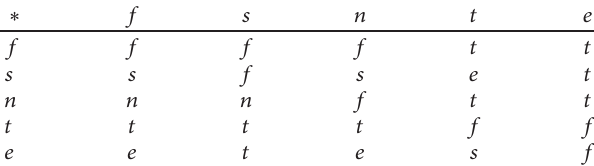
Table 5: Cayley table of the binary operation ∗ .